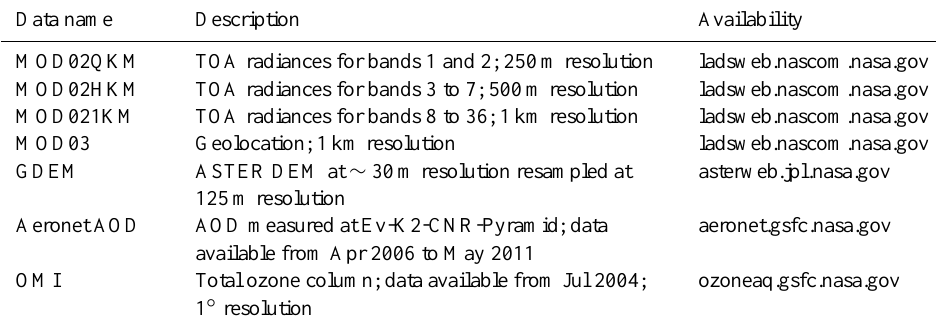
Table 1. MODImLab